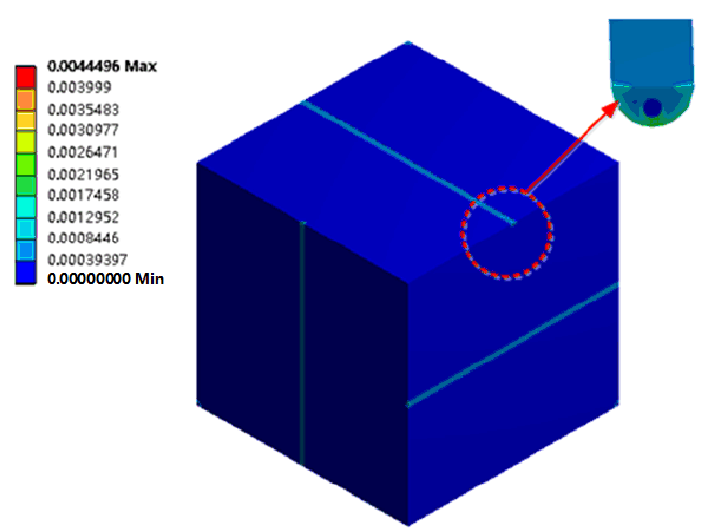
Figure 9. The equivalent strain of the sensor under hydrostatic pressure 50 MPa (The value on the graph is ε ).